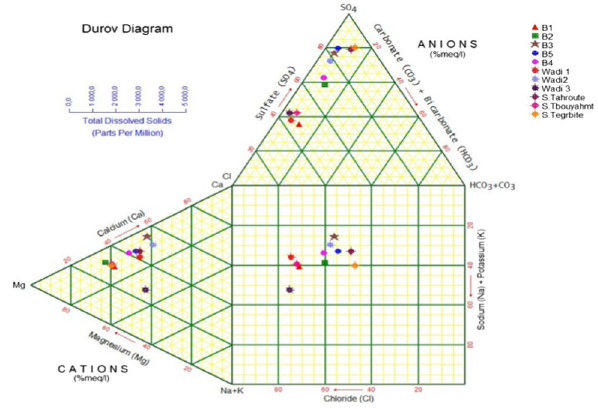
Fig. 5 Diagram of Durov representing the major element concentra- tions of El Ouldja